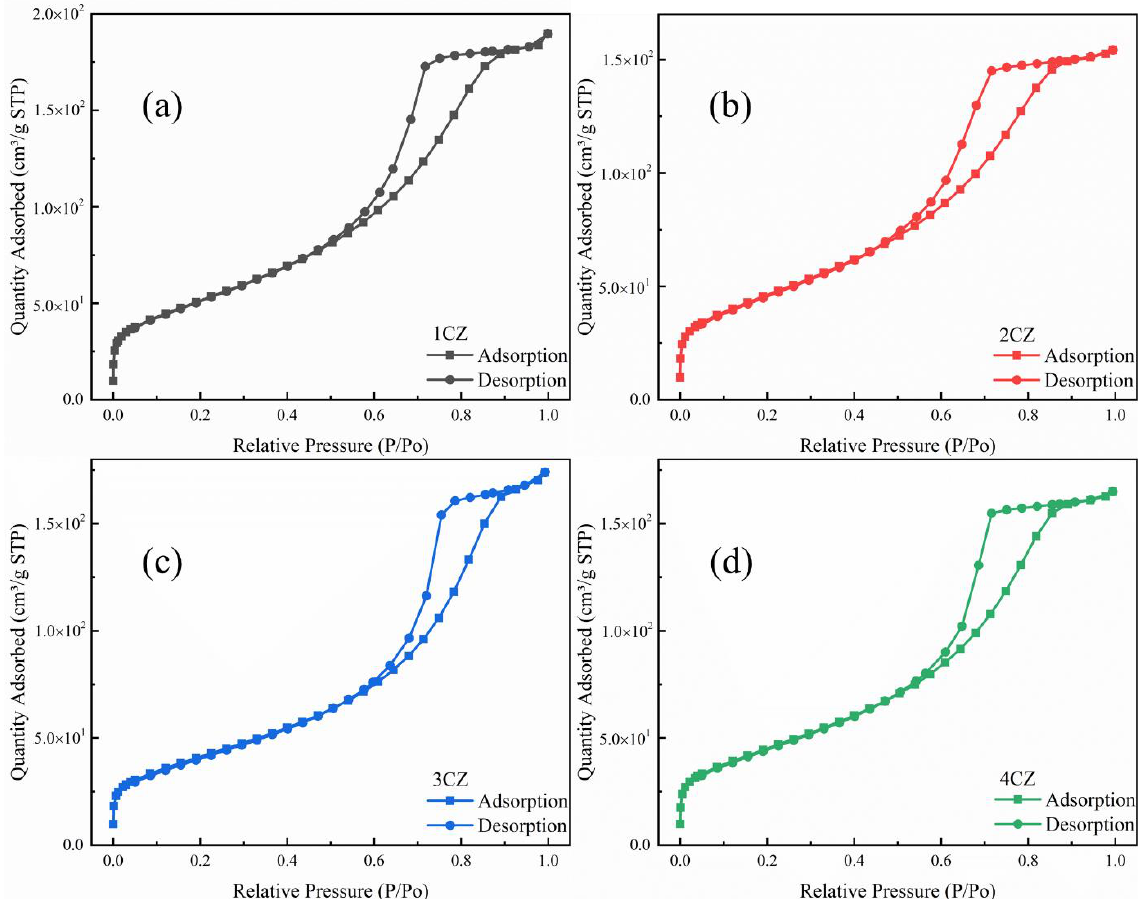
Figure 8. Isotherm linear plot for the CZ nanoparticles, ( a ) 1CZ; ( b ) 2CZ; ( c ) 3CZ; ( d ) 4CZ.